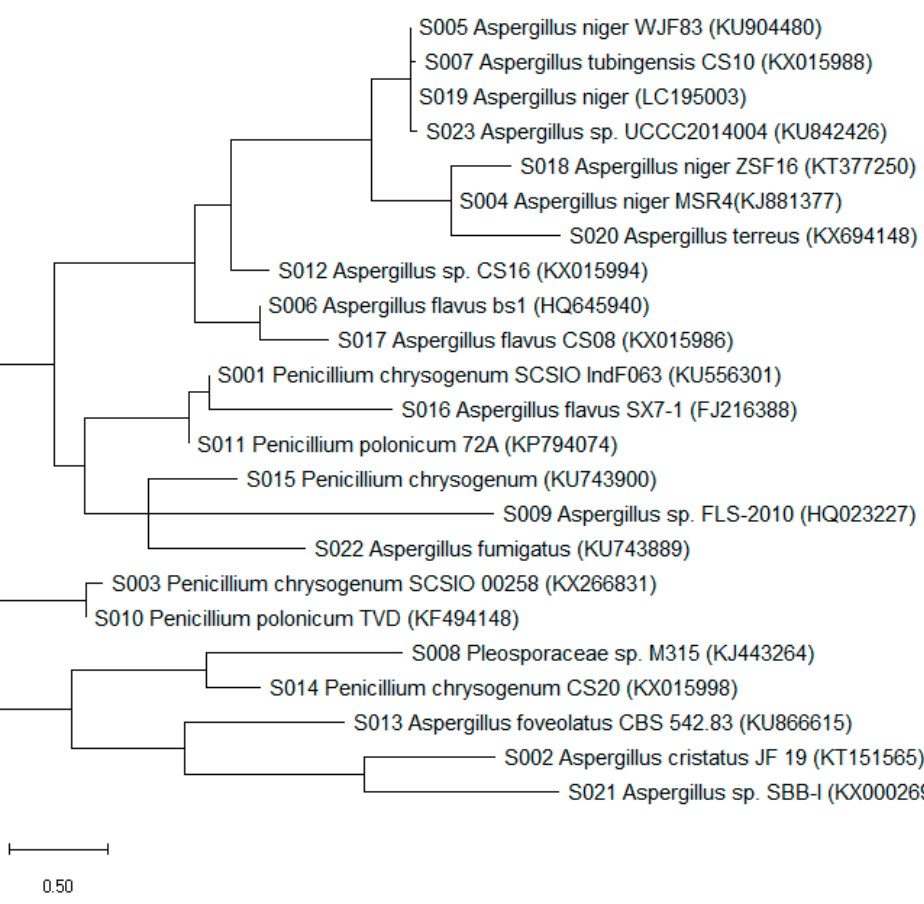
Figure 3. The structure of terrein.